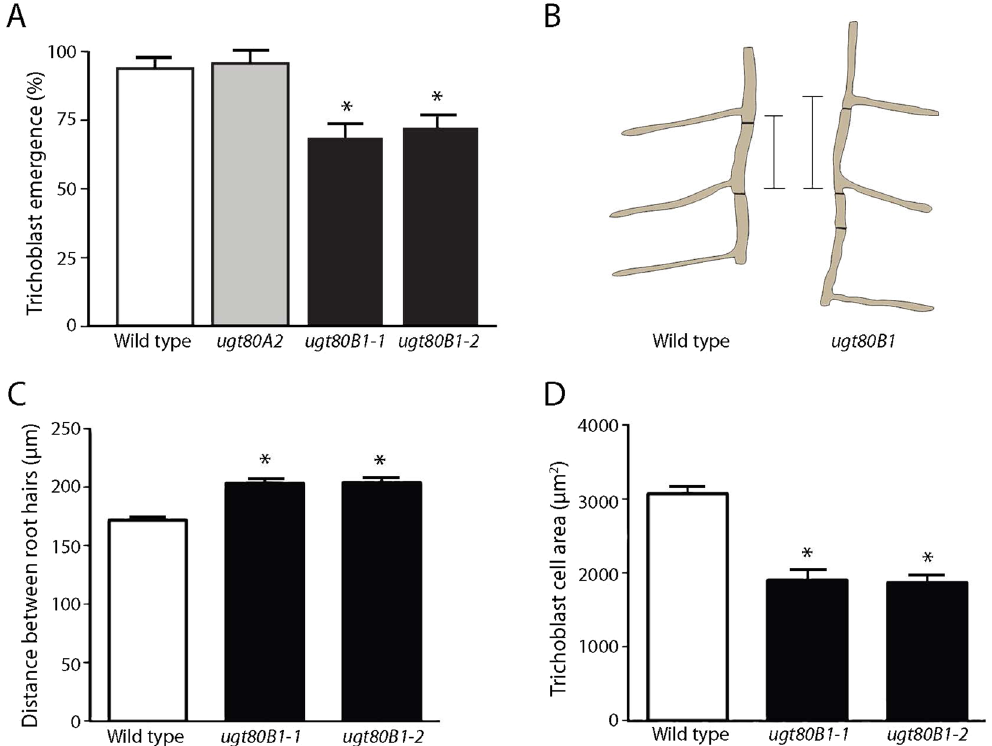
Figure 2. Aberrant epidermal root hair distribution in ugt80B1 mutants. ( A ) Mean emergence of trichoblasts (%) in H position cell files in the roots of wild type, ugt80A2 ugt80B1–1 , and ugt80B1–2 mutant lines. Both ugt80B1 mutant lines differ significantly from wild type ( p < 0.001, Student’s T-test). ( B ) Cartoon to illustrate the difference in distance between adjacent root hairs in an H-cell file in wild type and ugt80B1 mutants (scale bar = 100 μ m). ( C ) Mean distance between root hairs in wild type, ugt80B1–1 and ugt80B1–2 mutants (P < 0.001, Student’s T-test, n = 32). ( D ) Mean trichoblast cell area in wild type, ugt80B1–1 and ugt80B1–2 mutants (P < 0.05, Student’s T-test, n = 19). Asterisks indicate statistical significance, error bars indicate standard